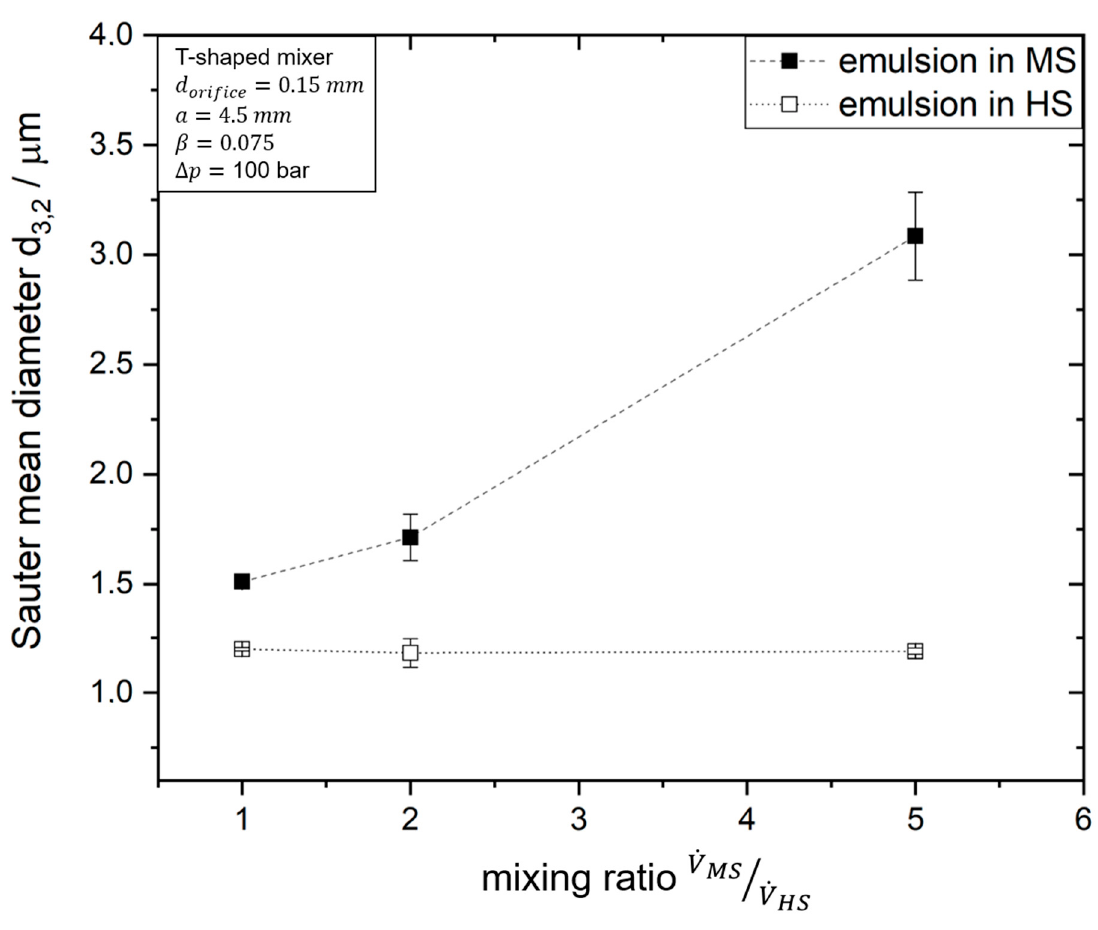
Figure 9. Influence of mixing ratio on d 3,2 for ∆ p = 100 bar.